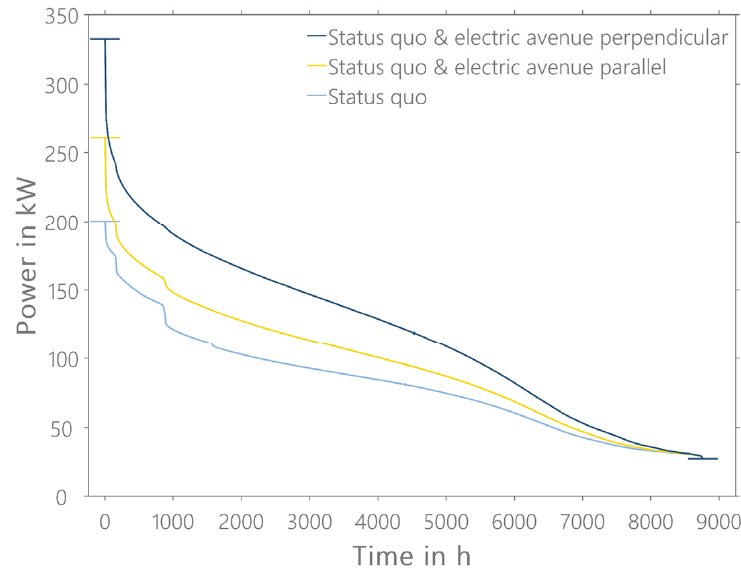
Figure 19. Annual load duration curve at the transformer.